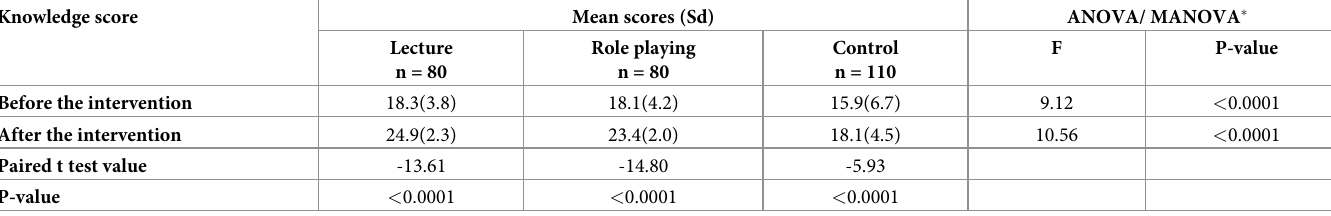
Table 2. Comparison of the knowledge between the groups before and after the